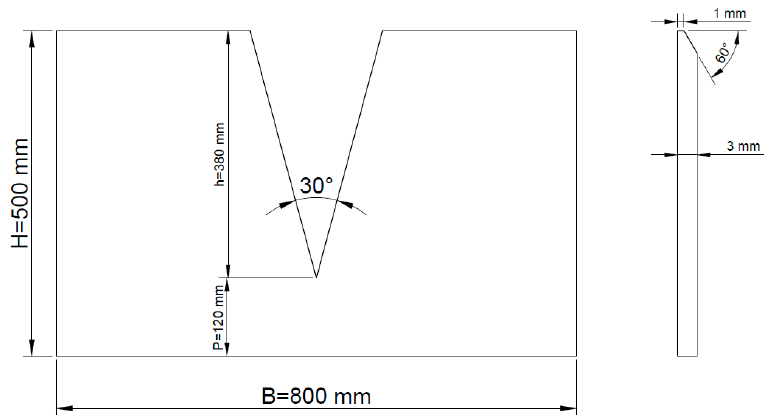
Figure 1. Weir cross-section for Green Infrastructure (GI) flow measurements.